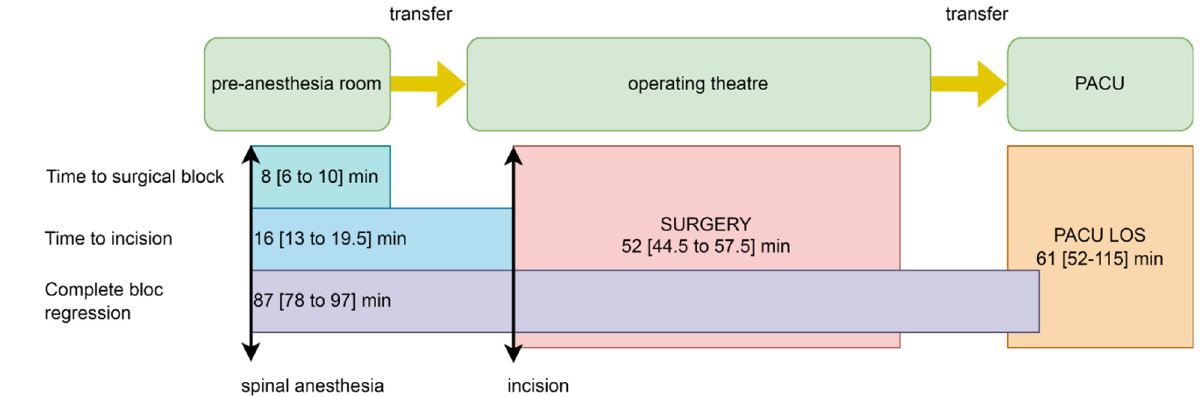
Figure 1. The sequence of anaesthesia, surgery, and PACU in the overall studied population. PACU— post-anaesthesia care unit; LOS—length of